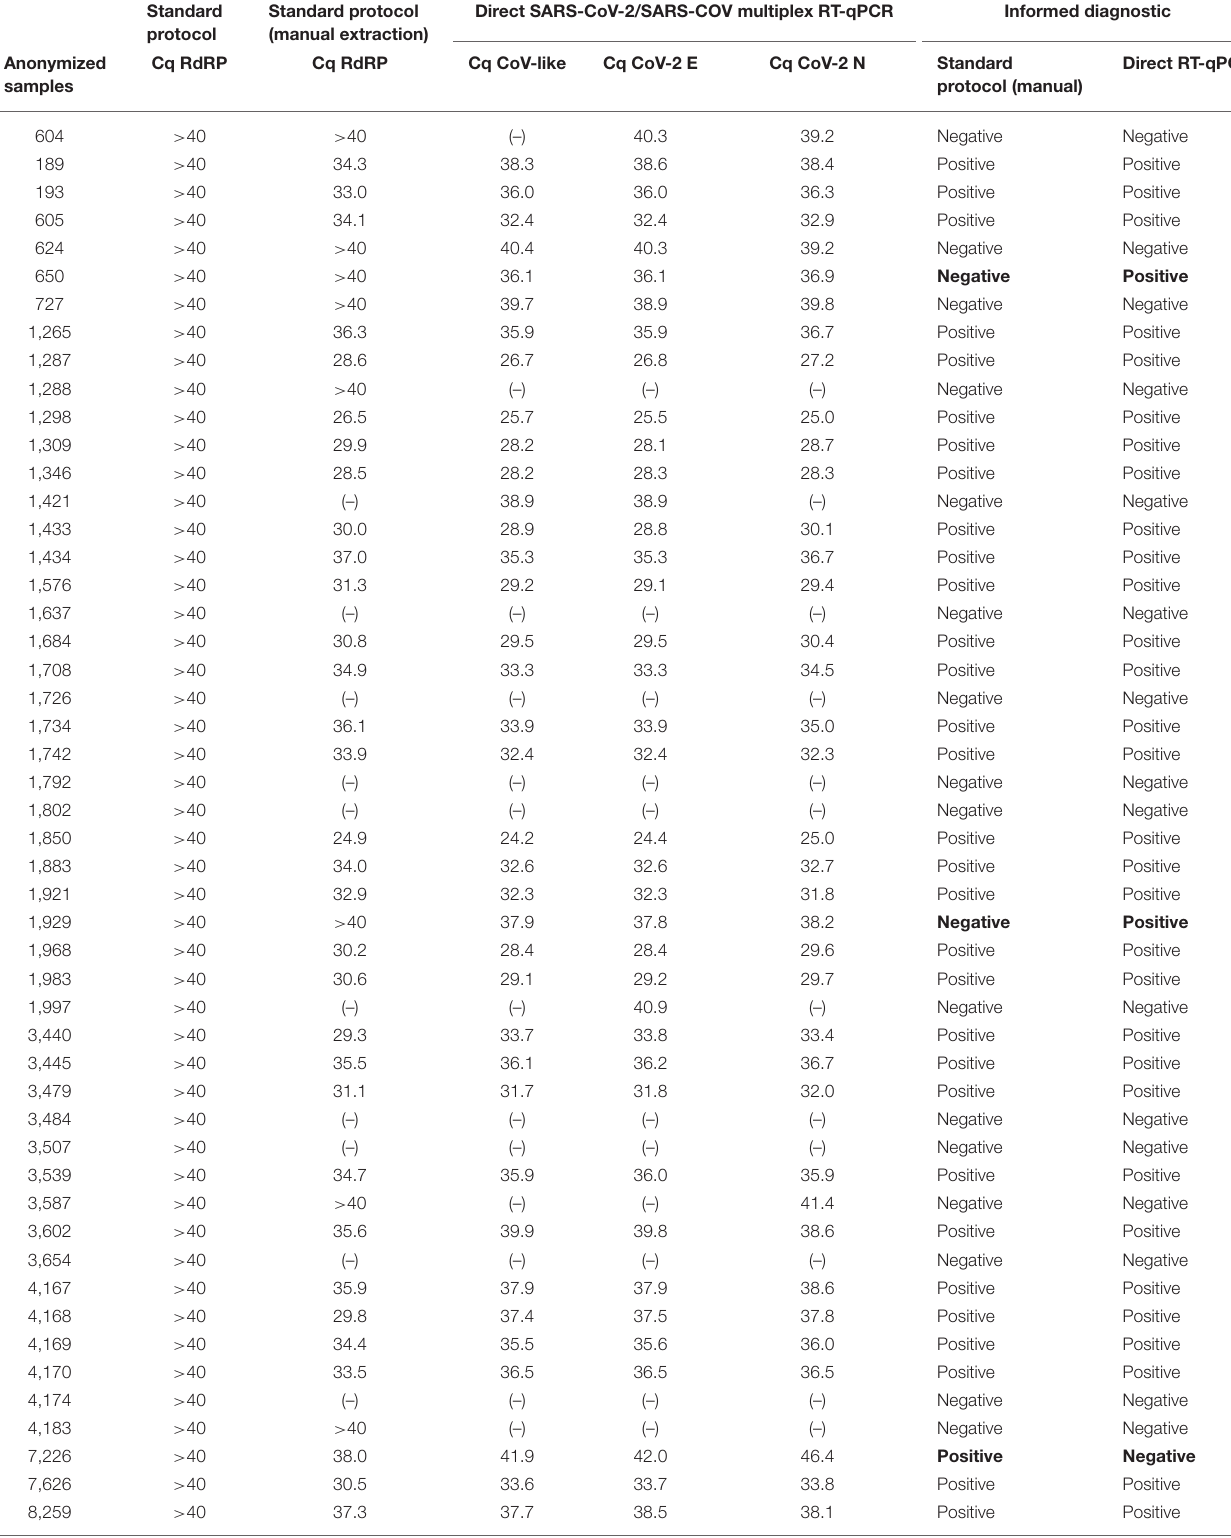
TABLE 4 | Analysis of concordance in the classification of 50 problematic historical samples, which were re-processed using the direct RT-PCR validated protocol. Standard